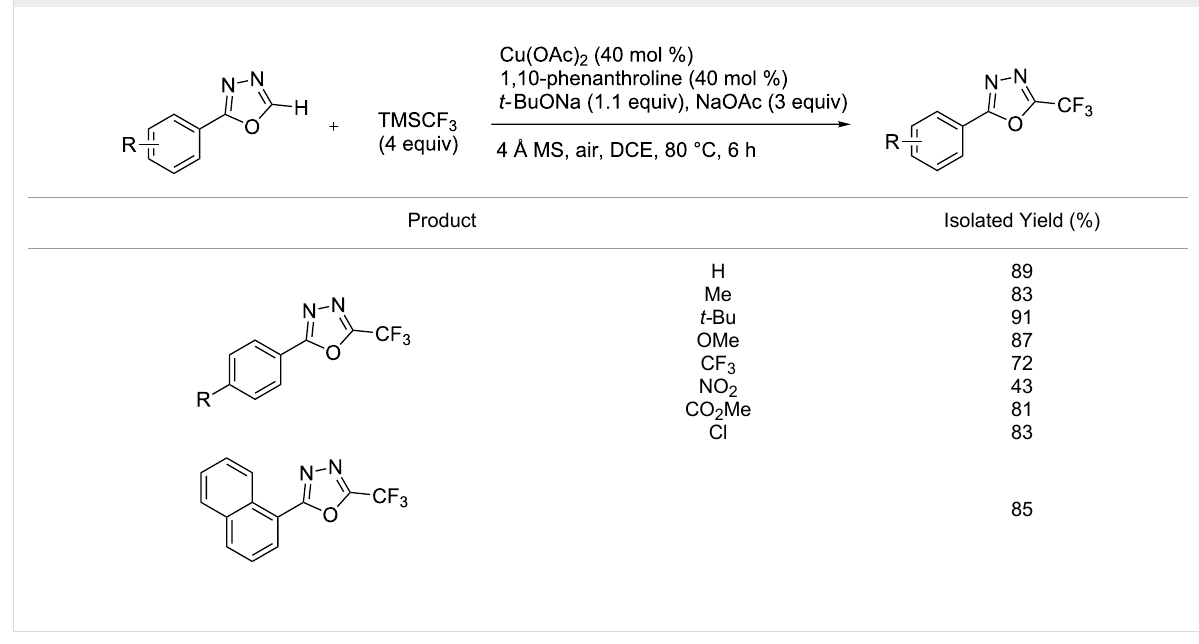
Table 20: Qing’s Cu-catalyzed trifluoromethylation of 1,3,4-oxadiazoles with the Ruppert–Prakash reagent [91].